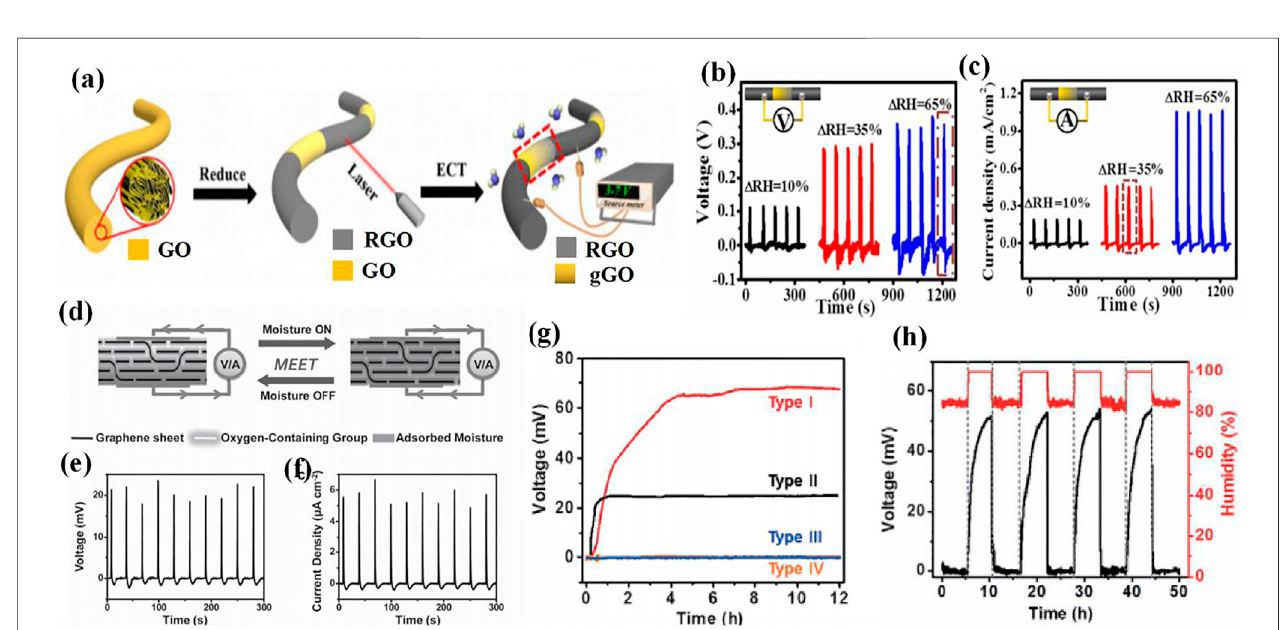
FIGURE 4 | (A) Schematic illustration of the process of RGO-GO structure graphene fi ber preparation. First, the GO fi ber is prepared by wet spinning method. Then, it is reduced by laser selective writing. Finally, the distribution of functional groups is varied by electrochemical treatment. (B) Voltage and (C) current density responsesoftheRGO-GOunitundermoisturestimulation(Figuresreprintedfromref.79withpermission.Copyright2017;Elsevier).Theinsetsshowthetestingcircuits. (D) Schematic illustration of the MEG cycle. V and A represent the induced voltage and current along the direction of arrows, respectively. (E) Voltage and (F) current output cycles of a prototype MEG device of g-GOF in response to intermittent and periodic RH variation ( Δ RH (cid:2) 30%) (Figures reprinted from ref. 80